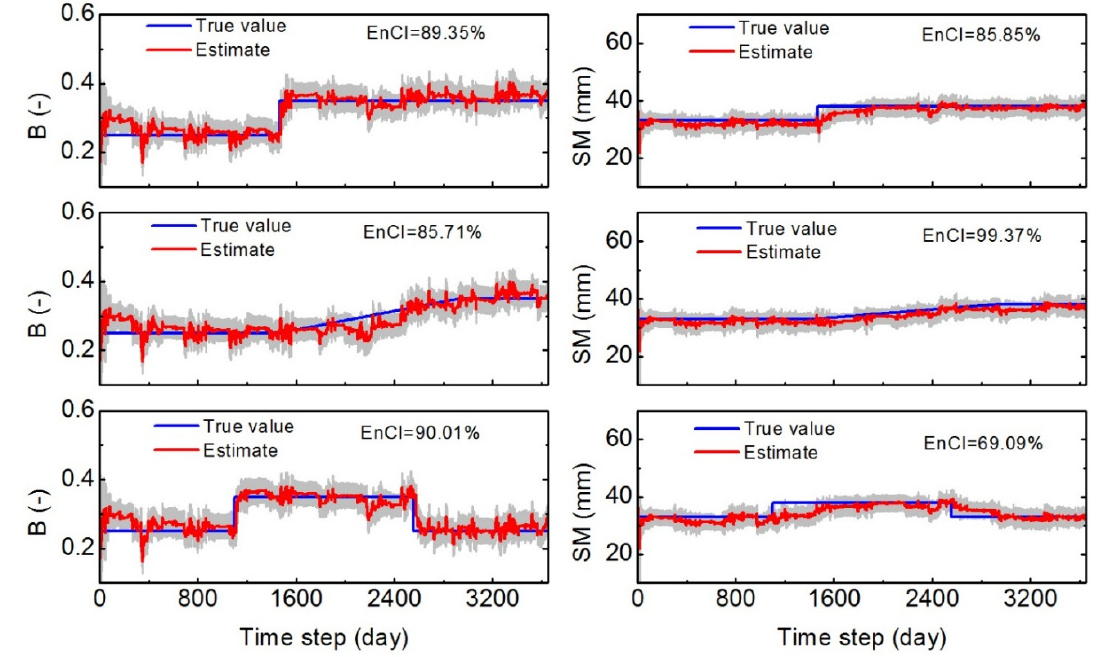
Figure 2. Tracing parameter changes for the three non-stationary cases of the sudden ( top panel ), the gradual ( middle panel ) and the rotational changes ( bottom panel ).